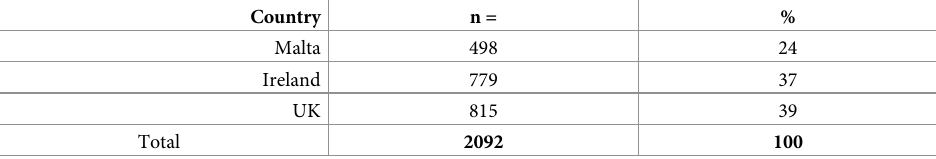
Table 1. Sample frame distribution of ERN survey respondents by